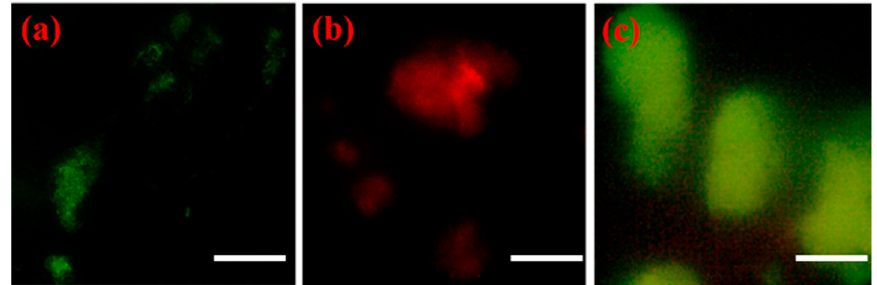
Figure 3. High resolution microscope image of ( a ) GOx@Cu(Im) 2 − RhB, ( b ) Cyt c @Cu(Im) 2 − FITC and ( c ) GOx − RhB and Cyt c − FITC@Cu(Im) 2 (scale bar is 15 µm).